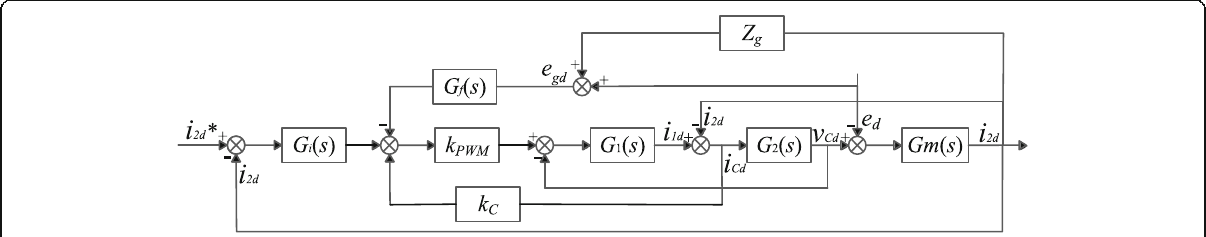
Fig. 2 Active damping control block diagram based on grid voltage feed-forward